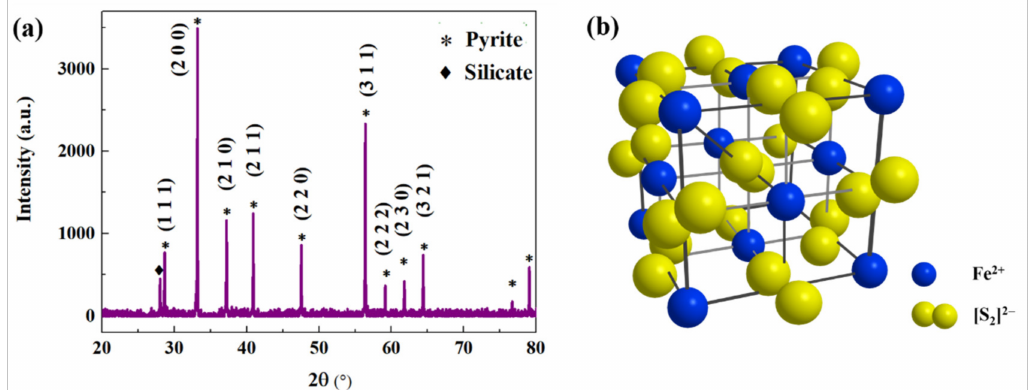
Figure 4. ( a ) The XRD pattern of original pyrite and ( b ) the crystal structure of FeS 2 . A typical voltage transient of pyrite is presented in Figure 5 (blue curve). When the sample surface was irradiated at t 1 = 0 s under the laser pulse with E in = 47.5 mJ, the pulse signal rose rapidly till the maximum value (V p ) of 0.0196V at t 2 , and then slowly decreased. The rise time of ~15.8 ns, with the rise time being defined by t 2 − t 1 , indicates that